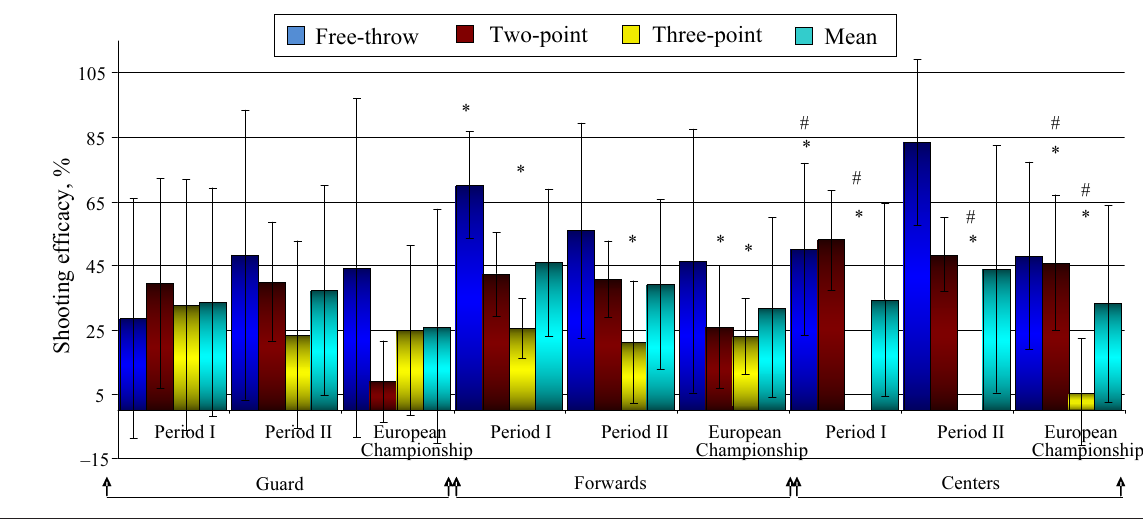
Figure 2. Efficiency of shooting from different positions in LC’2011 and EC’2011 by LBC and Lithuanian national youth female team Note. * – p < 0.05 between guard and others (forwards and centers), # – p < 0.05 between forwards and